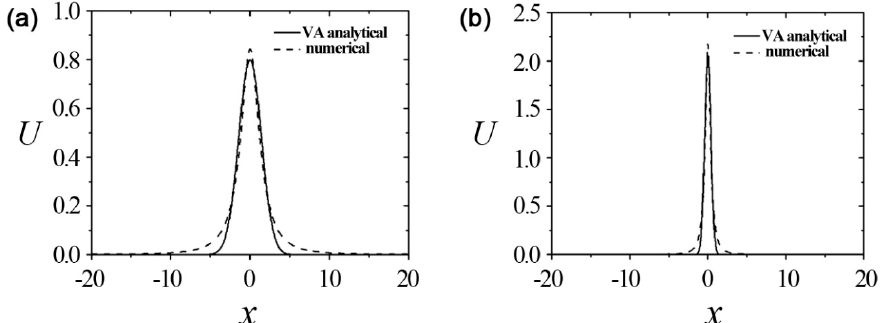
Figure 1. Profiles of solitons with µ = − 0.3 ( a ) and − 2.0 ( b ), predicted by the VA based on the Gaussian ansatz (23) and Euler–Lagrange equations (26) and their counterparts produced by the numerical solution of Equation (8) with Lévy index α = 1.5 and g = 1. Reprinted with permission from Reference [39]. Copyright 2020 Elsevier.